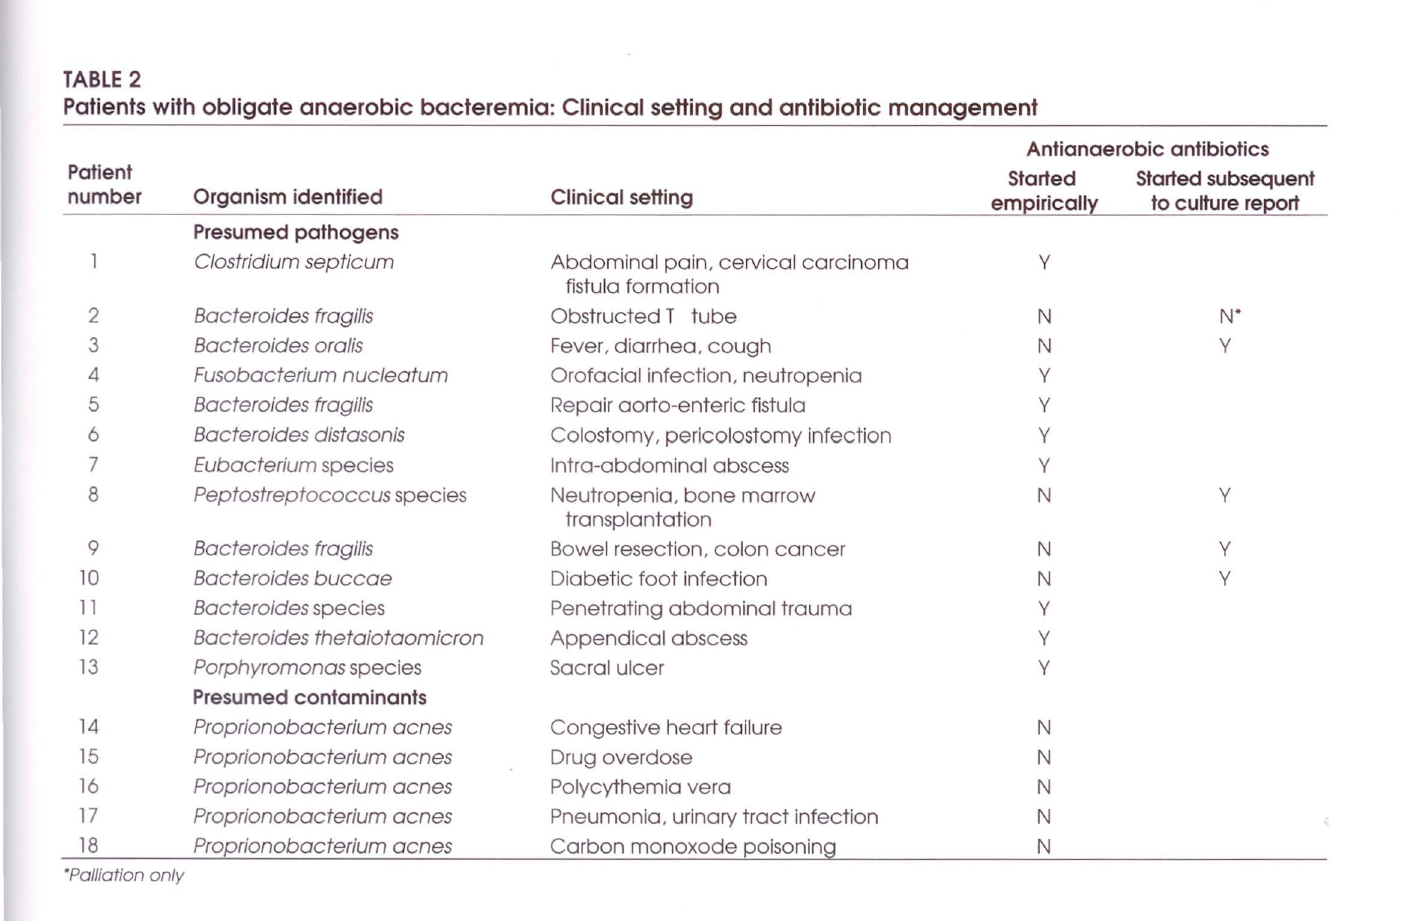
Antianaerobic antibiotics